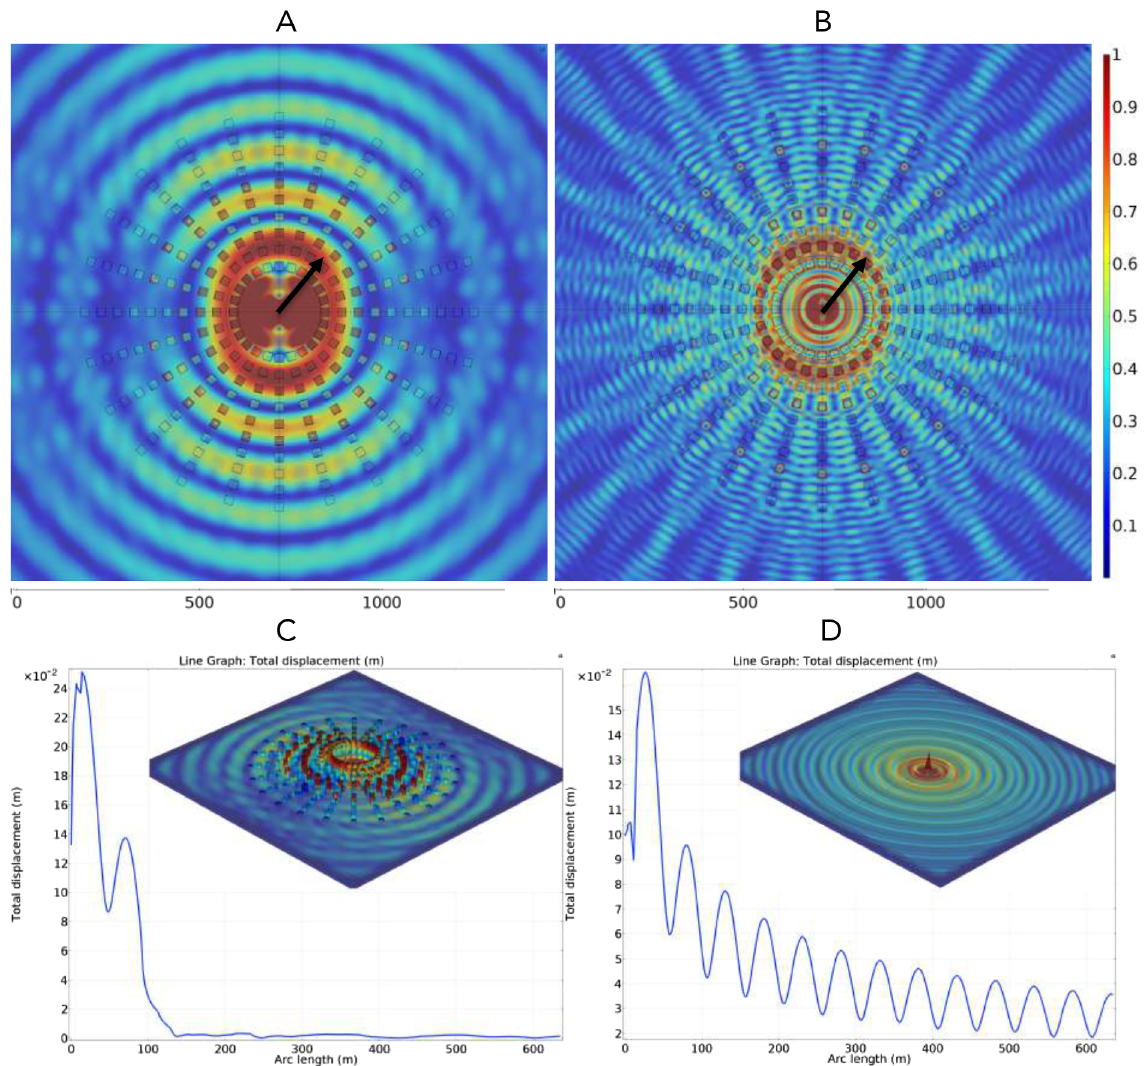
Fig. 8. Cloaking of a seismic source located inside the core of the meta-city cloak at 10Hz (A), (C). These are concrete buildings on a concrete plate. One notices in (A), (C) that the fi eld outside the cloak has reduced amplitude and is almost isotropic, which is a hallmark of cloaking a sensor in optics. The benchmark of a 10 Hz seismic source in a homogeneous plate in (D) makes clear the cavity like effect of the invisibility region in (A),